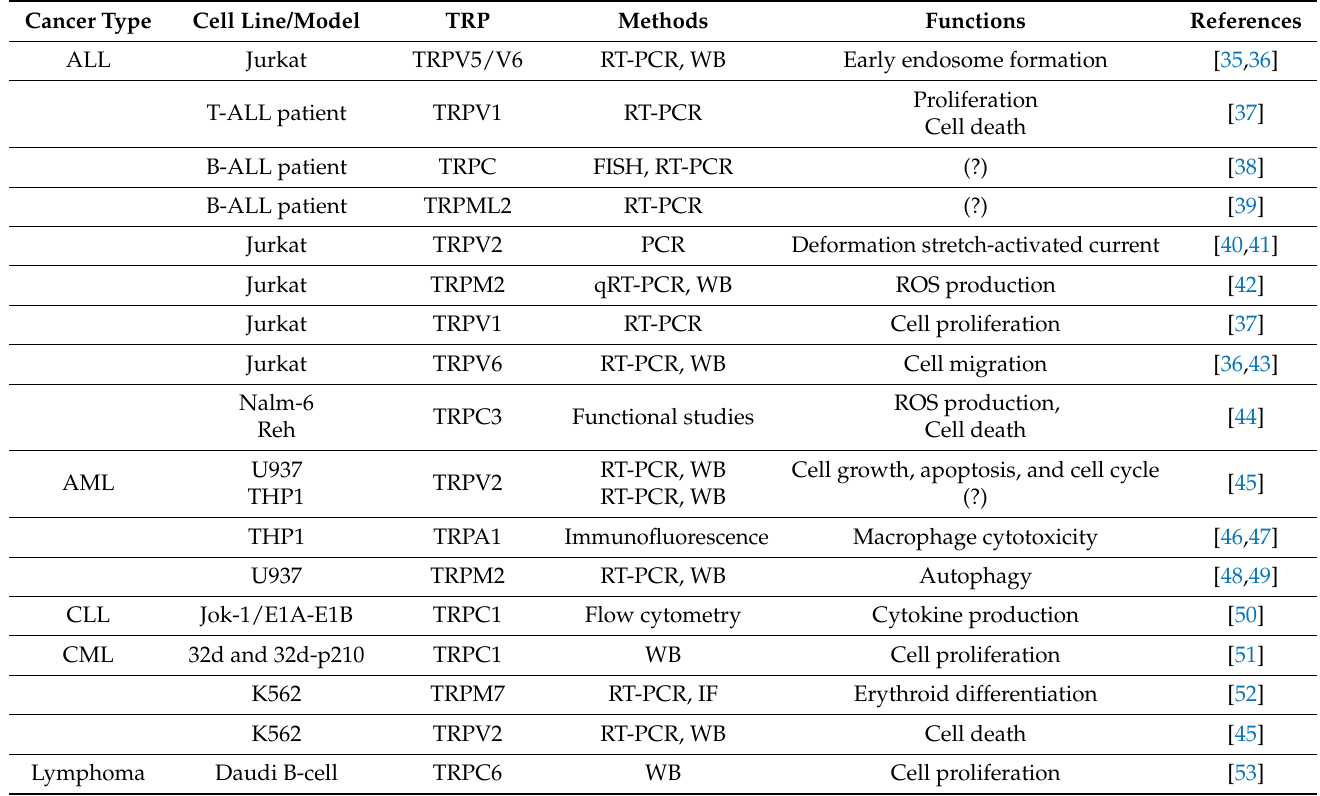
Table 2. Expression of TRP channels in leukaemia and